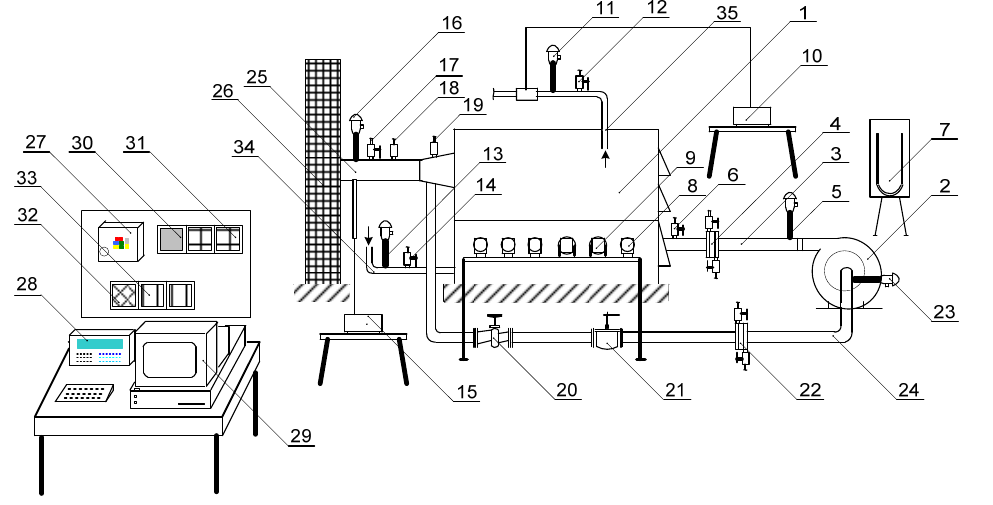
Figure 1. Boiler plant of the “Ekoprodukt” manufacturer from Novi Sad with its measurement and regulation equipment (1-hot-water boiler, 2-combustion air fan, 3-tube for air supply into the combustion chamber, 4-airflow differential pressure meter with orifice plates (conic edge), 5-Pt100 temperature sensor for measuring air temperature, 6-sensor for measuring pressure of combustion air, 7-“U” tube, 8-differential pressure transmitters, 9-pressure transmitter, 10-ultrasonic water flowmeter, 11-Pt100 temperature sensor for measuring the temperature of output water, 12-sensor for measuring pressure of output water, 13-Pt100 temperature sensor for measuring the temperature of inlet water, 14-sensor for measuring pressure of incoming water, 15-flue gas analyzer, 16- thermocouples for measuring flue gas temperature, type K (Ni-CrNi), 17-sensor for measuring pressure of flue gas, 18-oxygen lambda sensor without heater, 19-oxygen lambda sensor with heater, 20-shut-off valve, 21-gate valve, 22-airflow differential pressure meter with orifice plates (conic edge), 23-Pt100 temperature sensor for measuring the temperature of flue gas recirculation, 24tube for intake of recirculation flue gas, 25-flue gas canal, 26-chimney, 27 - frequency regulator for combustion air fan, 28-controller, 29-personal desktop computer, 30-expansion adapter EX-A1, 31-expansion module IO- PT4, 32-expansion module IO-ATC8-, 33-expansion module IO-AI4-AO2, 34-tube of inlet water supply, 35-tube of output